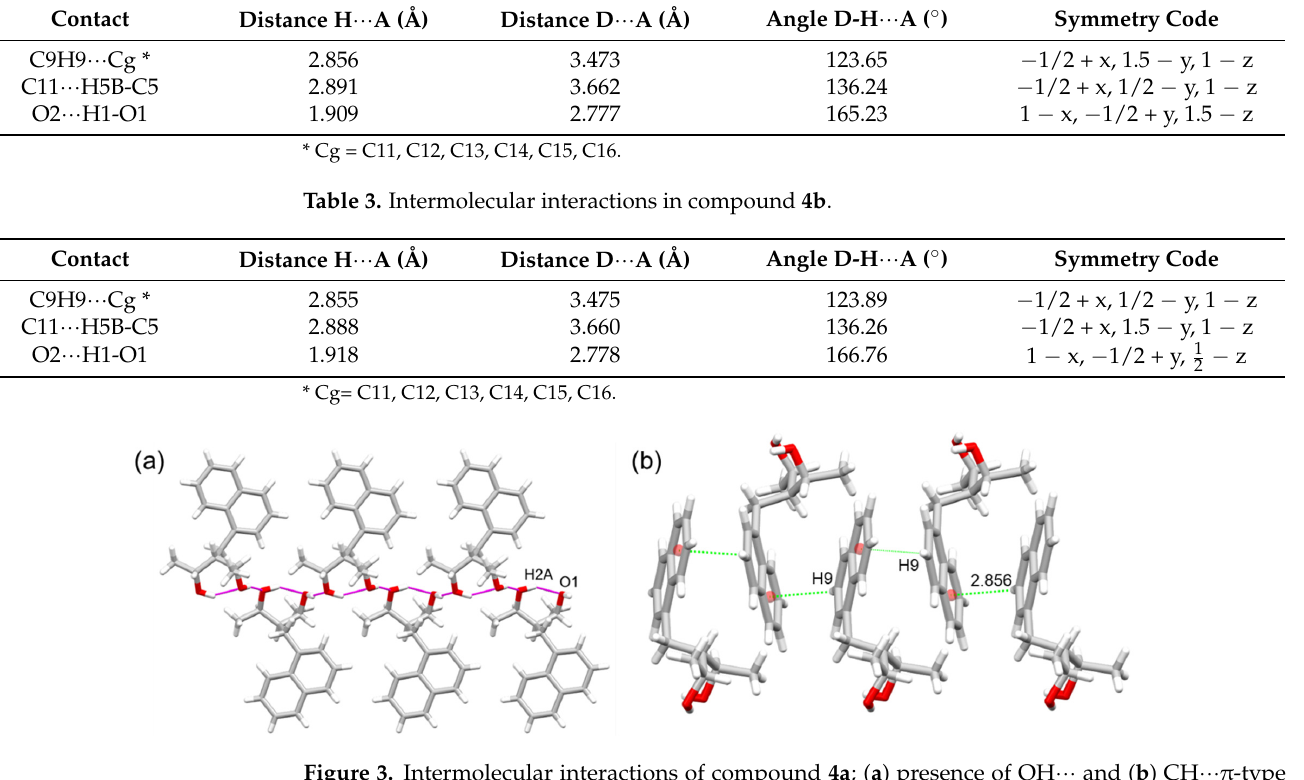
Table 2. Intermolecular interactions in compound 4a .